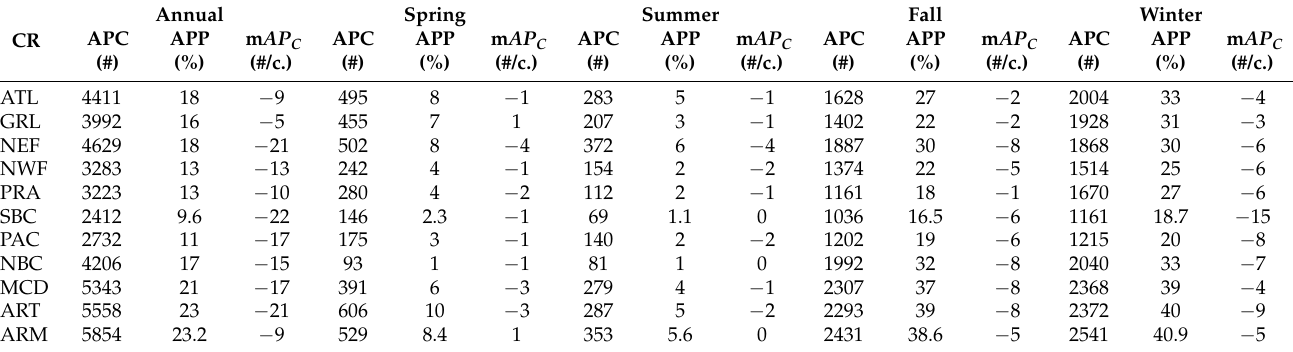
Table 7. Regional advective population counts, advective population participation, and advective population slope of counts reported per century (#/c.) “m” represents “slope”. APC—Advective Pop- ulation Count, APP—Advective Population Participation, and m AP c —Slope of Advective Population Count. “CR” represents “climate region”. ATL—Atlantic Canada, GRL—Great Lakes/St. Lawrence Lowlands, NEF—Northeastern Forest, NWF—Northwestern Forest, PRA—Prairies, SBC—South British Columbia Mountains, PAC—Pacific Coast, NBC—North British Columbia Mountains/Yukon Territory, MCD—Mackenzie District, ART—Arctic Tundra, and ARM—Arctic Mountains and Fiords.